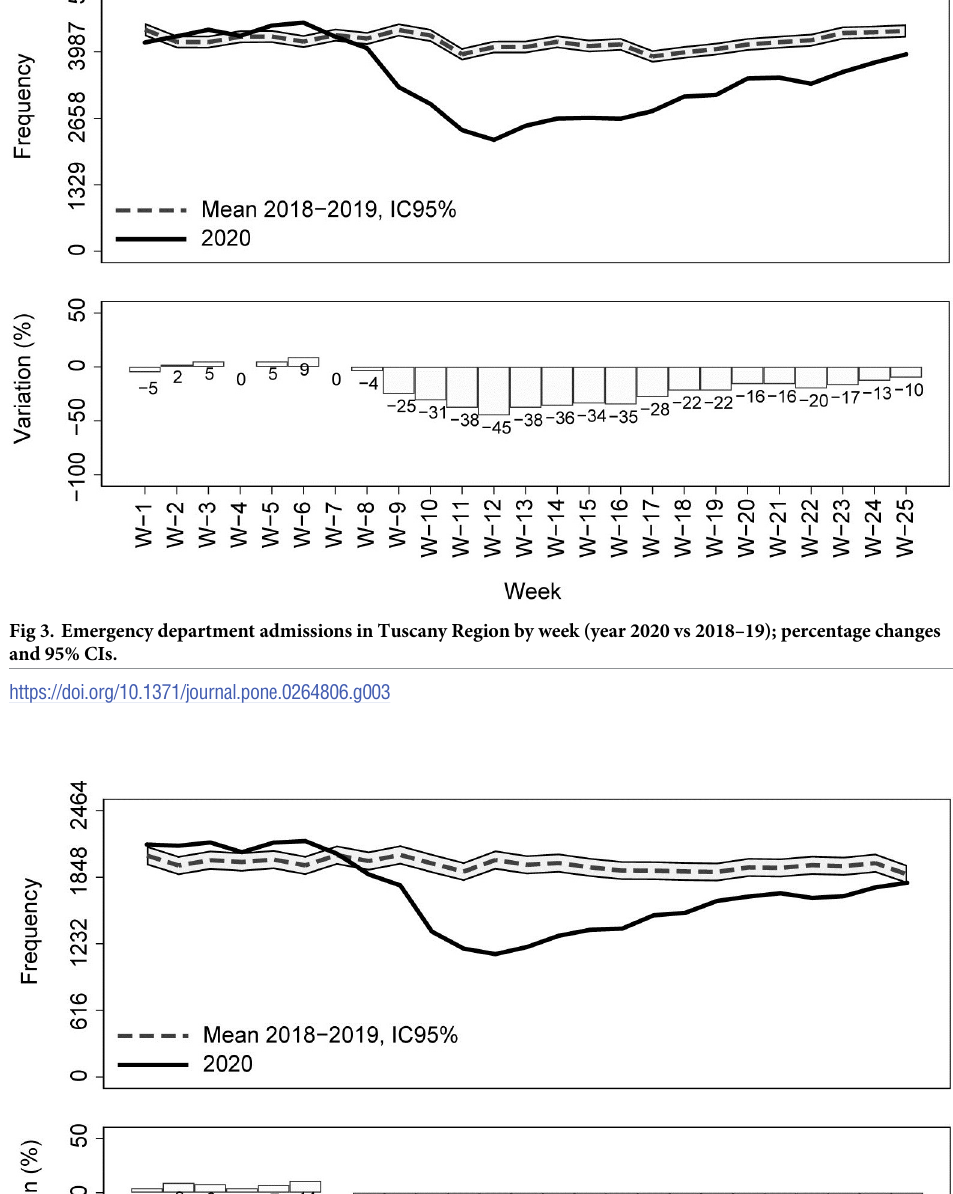
PLOS ONE | https://doi.org/10.1371/journal.pone.0264806 July 1, 2022 7 /